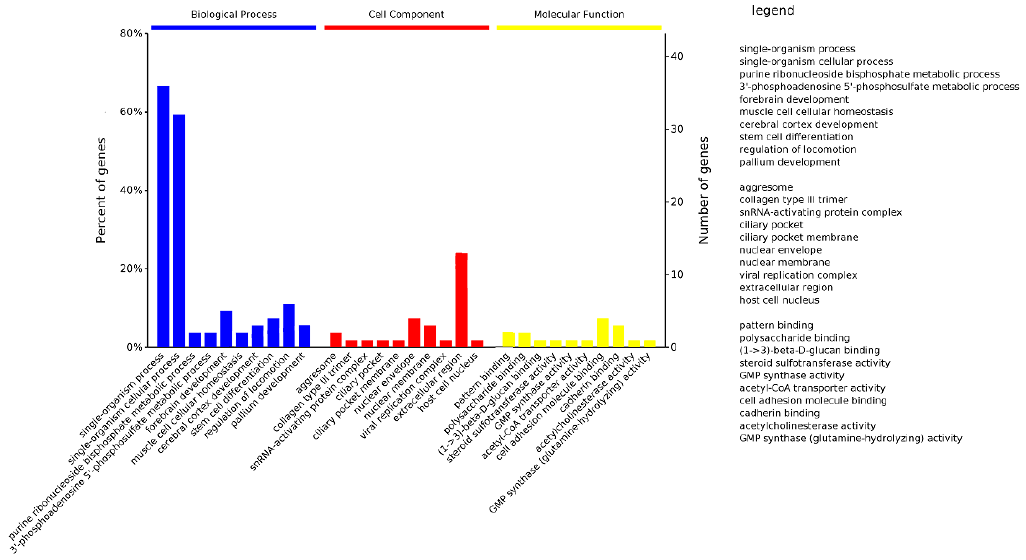
Figure 6. GO enrichment analysis of genes in selected regions of Anqing six-end-white pigs.